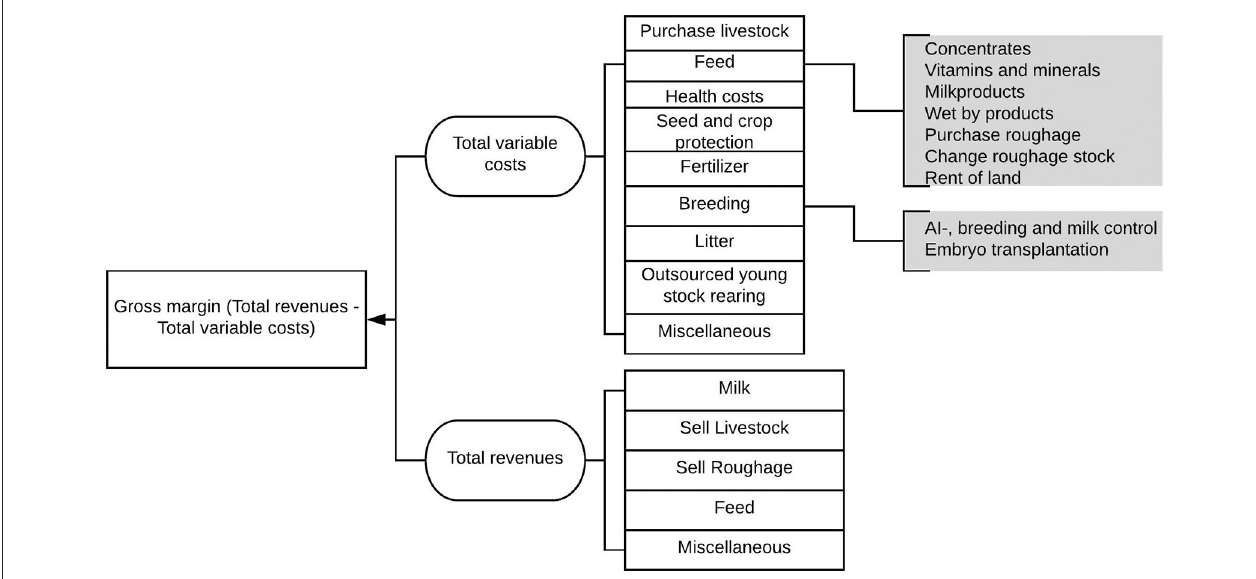
FIGURE 2 | Overview of revenues and costs accounted for in the gross margin of the herds for dairy production. Examples of miscellaneous costs are costs related to water, electricity and manure disposal. Examples of miscellaneous revenues are subsidies and rental of barn space. Feed revenues include, for instance, the sales of silage.